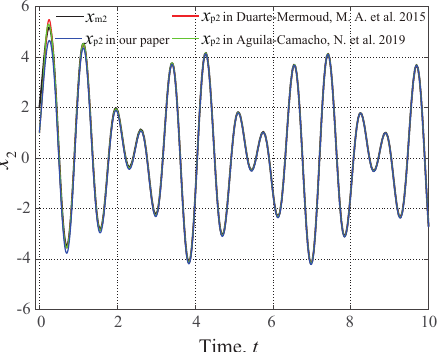
( t ) and x m ( t ) with the standard fractional order 2 2